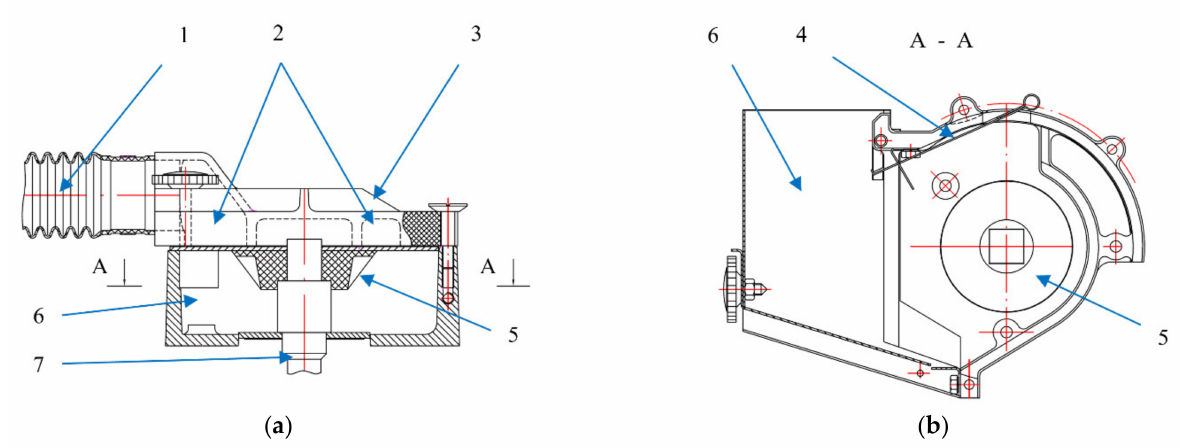
Figure 2. Scheme of the studied row unit’s seed meter: ( a ) Top view; ( b ) Lateral view; (1) vacuum hose; (2) depression chamber; (3) seed meter cover; (4) lamellar singulator; (5) agitator; (6) seed feeding chamber; and (7) seed meter shaft.